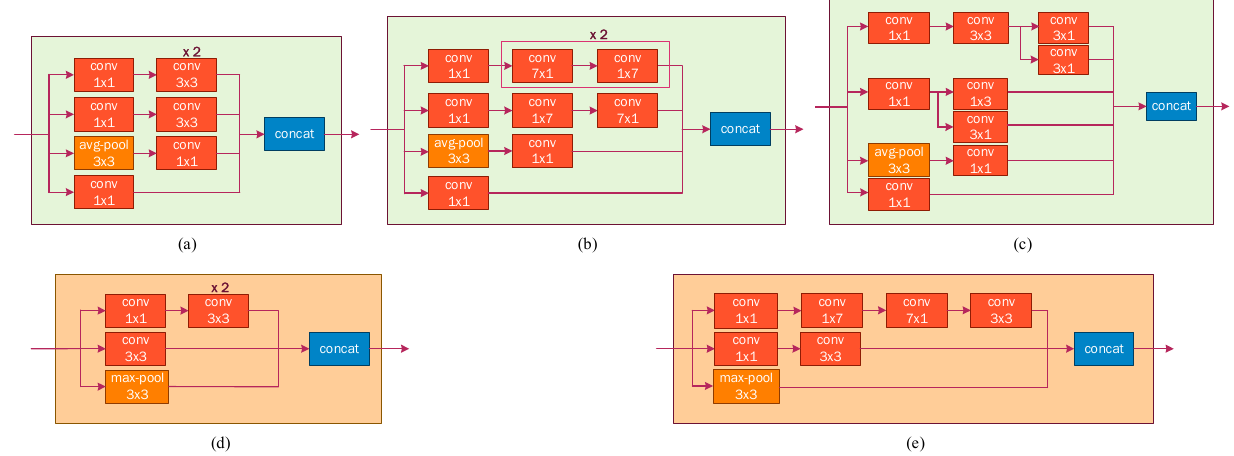
Figure 7. ( a ) Inception-A block, ( b ) inception-B block, ( c ) inception-C block, ( d ) reduction-A block, and ( e ) reduction-B.